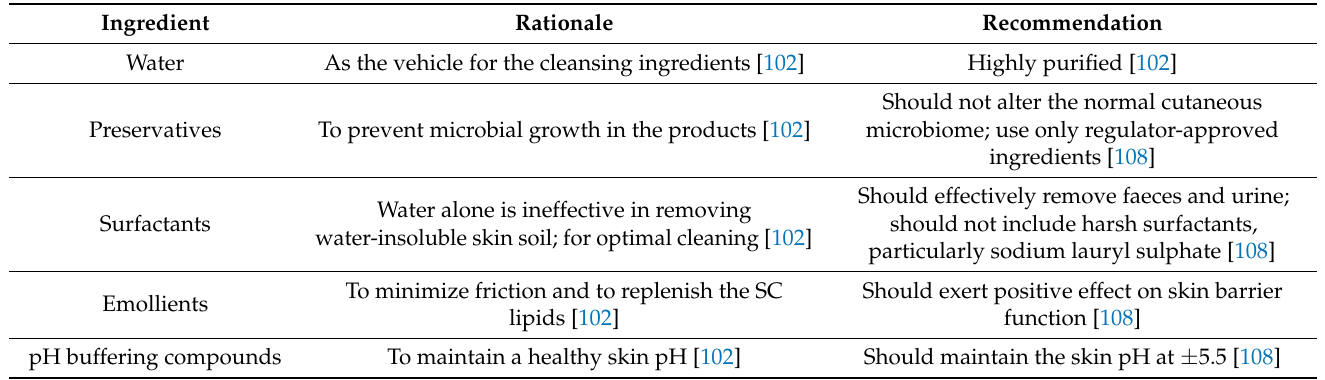
Table 5. Suggested requirements for components of baby wipe